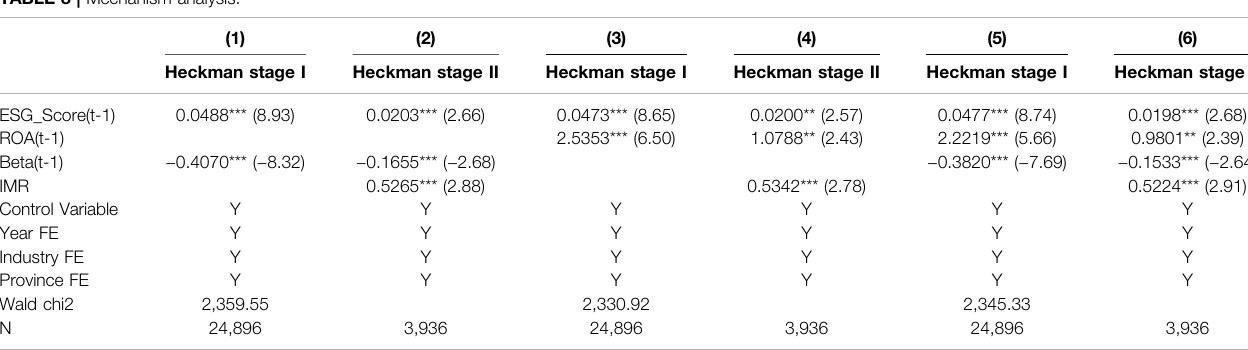
TABLE 8 | Mechanism analysis.